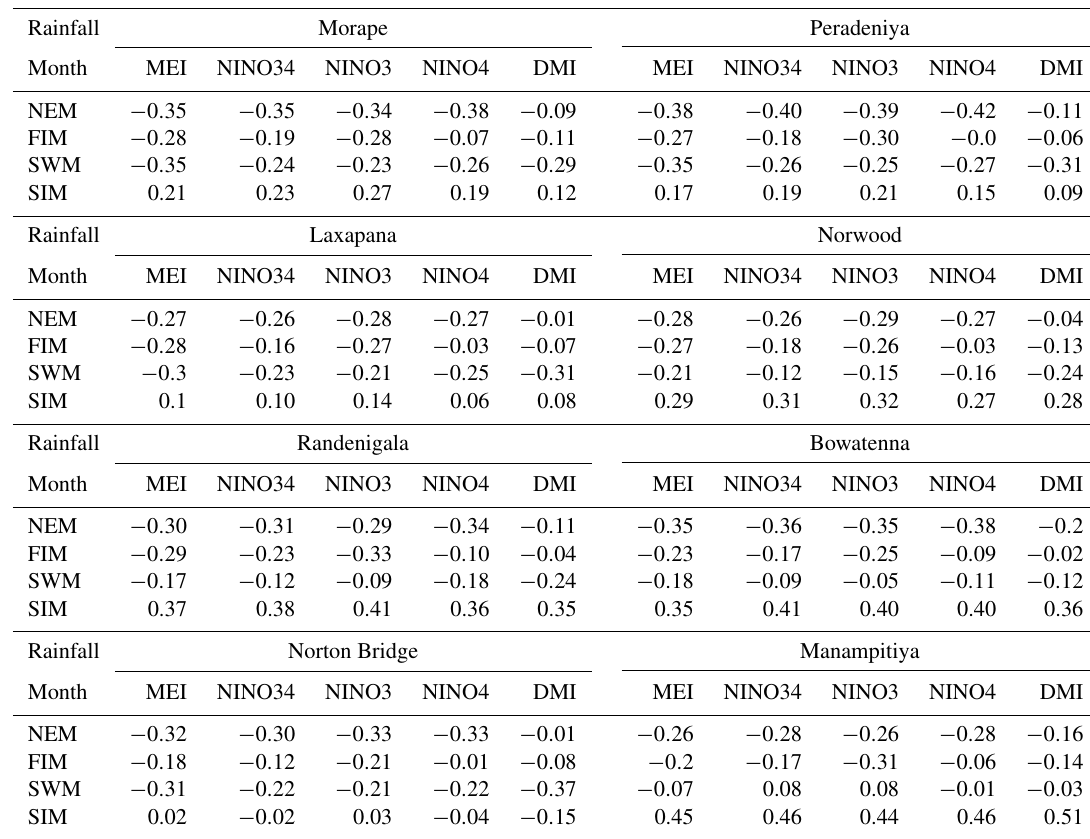
Table A1. Correlation analysis of rainfall anomalies and climate indices. Rainfall Morape Peradeniya